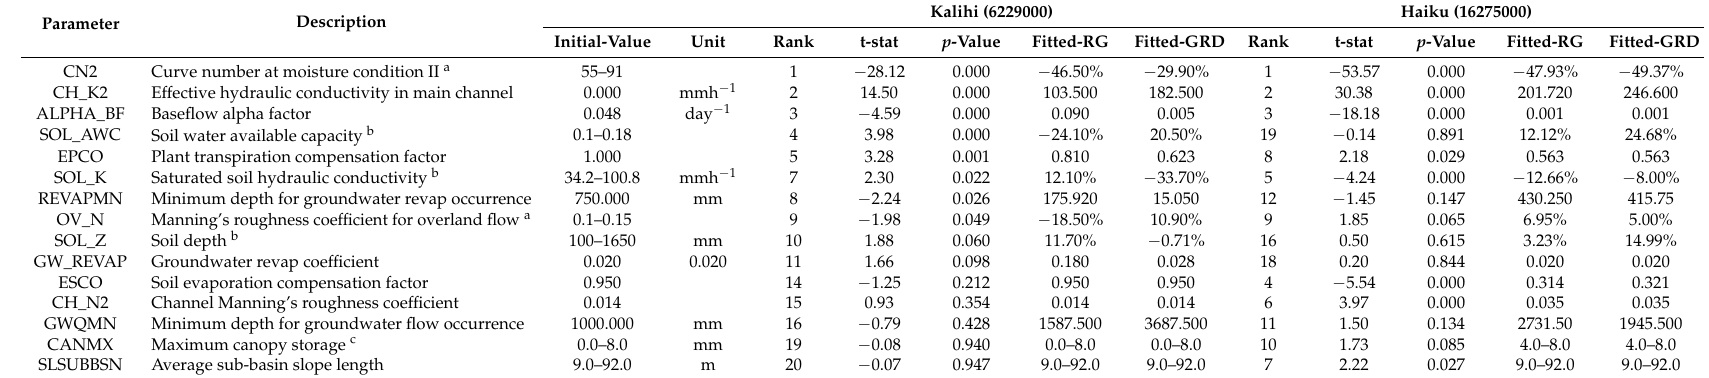
Table 3. Sensitivity rank of SWAT parameters and their corresponding calibrated values for Heeia and Kalihi